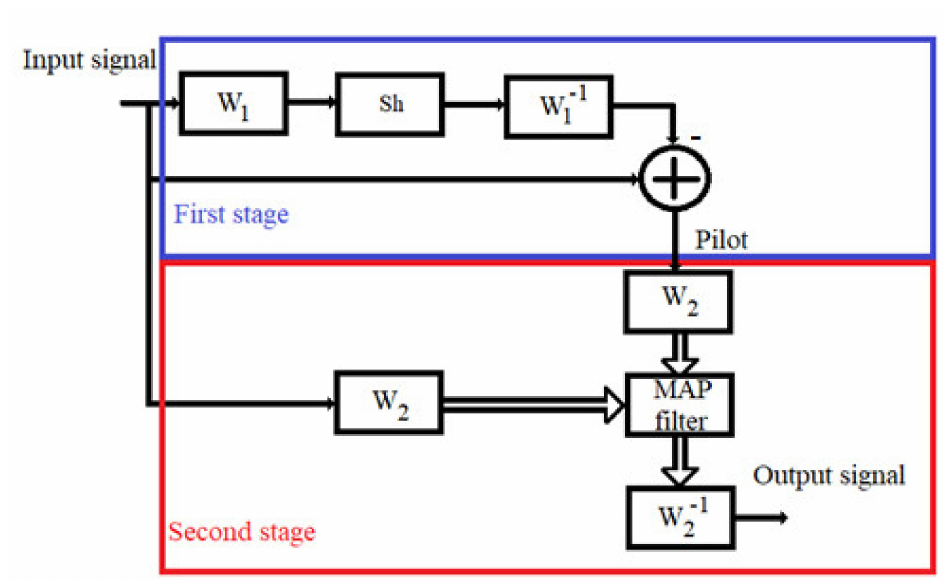
Figure 1. Two-stage denoising system